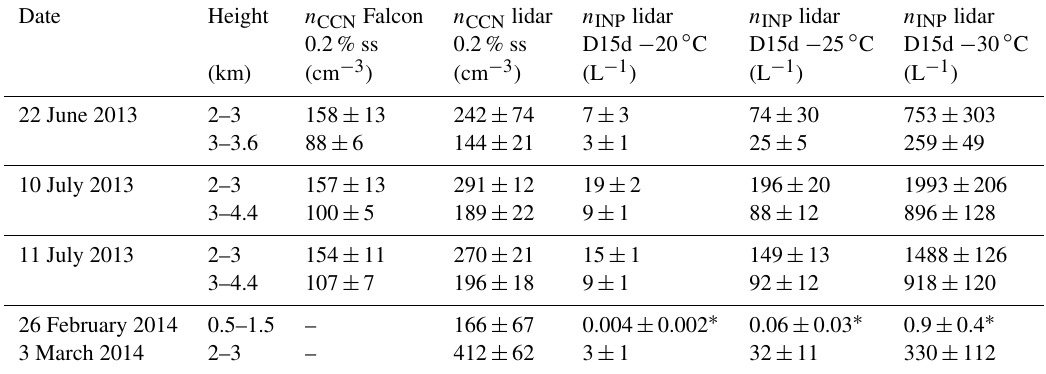
Table 5. Layer mean CCN and INP concentrations ( n CCN ; n INP ) in the upper ( > 3km) and lower (2–3km) part of the SAL from lidar and Falcon ( n CCN only). The standard deviation of the layer mean is given. The uncertainty range for the lidar retrieval is a factor of 2 for n CCN and 3 for n INP (not indicated). The immersion-freezing INP parameterization of D15d for dust at a constant temperature is used to give an estimate. CCN concentrations are given for 0.2% water supersaturation (ss). n CCN and n INP values for the observed dust–smoke mixture and the pure marine conditions (INP from M18m) measured at Barbados on 3 March 2014 and 26 February 2014, respectively, are added. Height n CCN Falcon n CCN lidar n INP lidar n INP lidar 0.2% ss 0.2% ss D15d − 20 ◦ C (km) (cm − 3